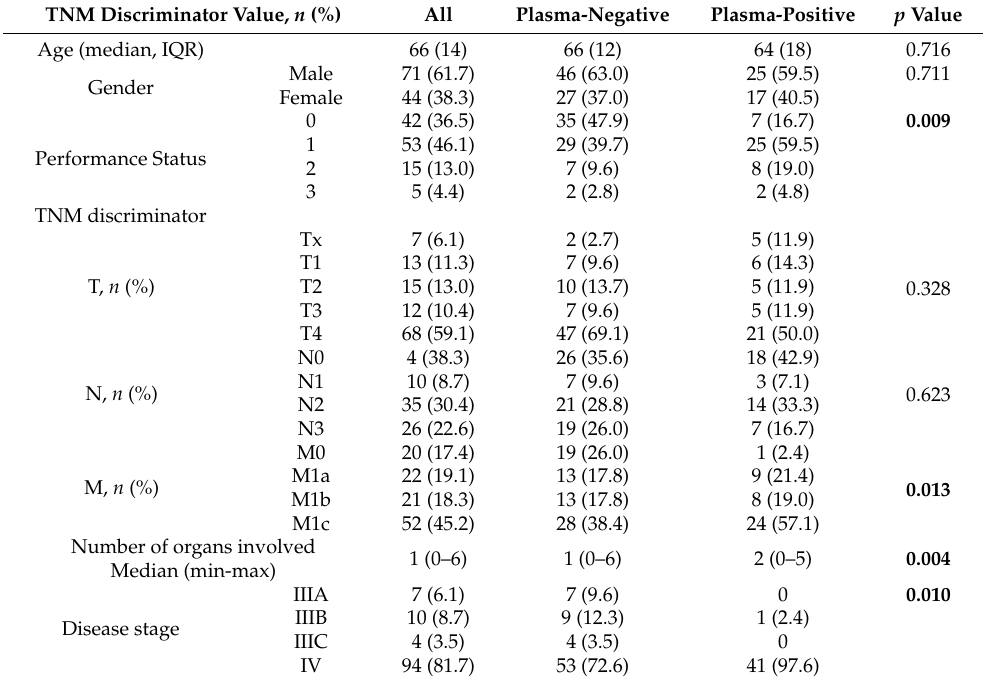
Table 4. Clinical factors determining ctDNA